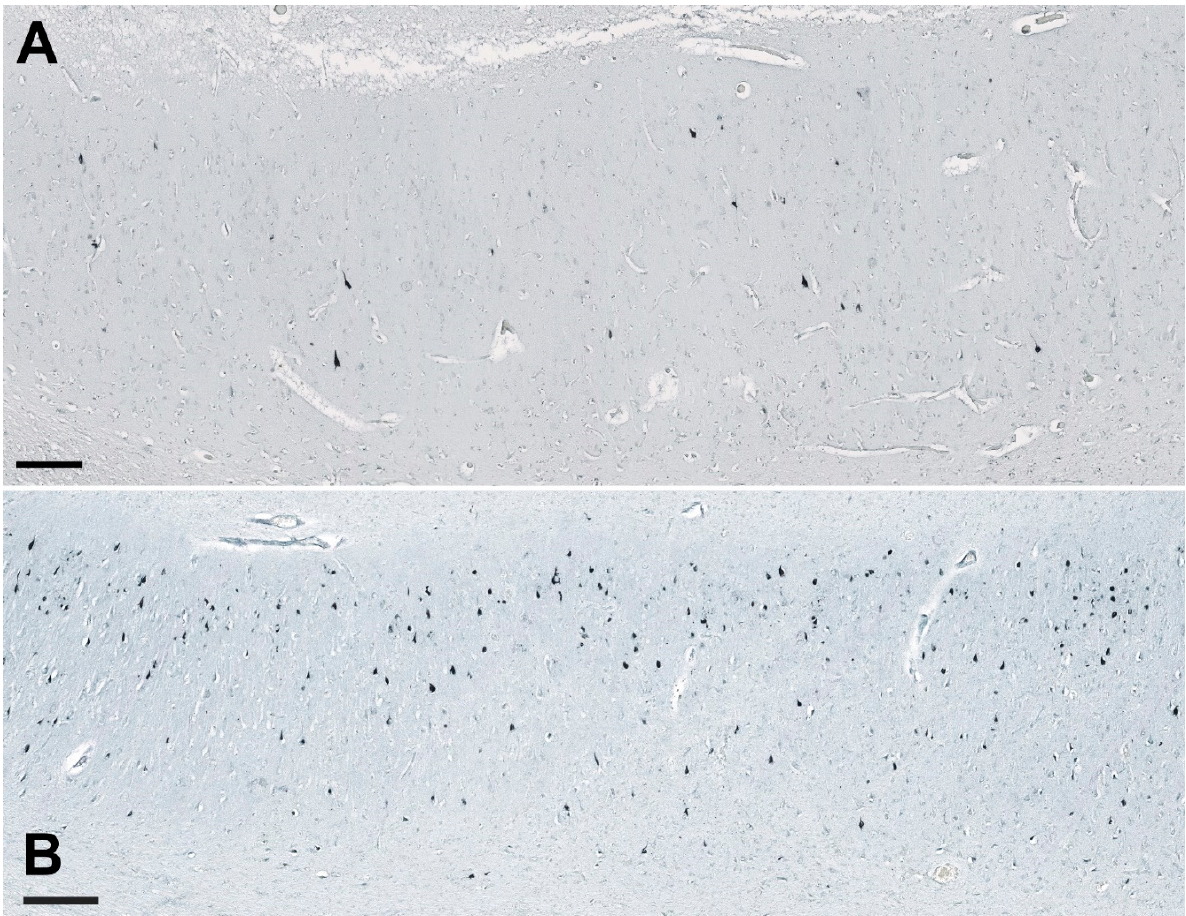
Figure 10. Immunostaining of the CASP-6 in the subiculum of the hippocampal formation in the HC (case HC9, subfigure A ) and the AD brain (case AD2, subfigure B ). The difference in the number of CASP-6-immunoreactive neurons between the HC and AD groups in the CA1 field was statistically significant (see Figure 4). Scale bars 250 μ m.